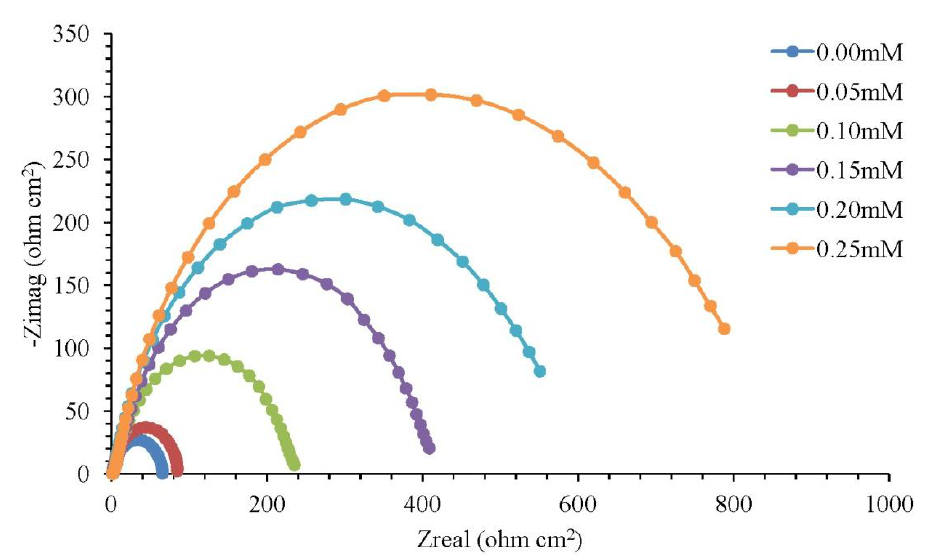
SO with different concentrations of the 2 4